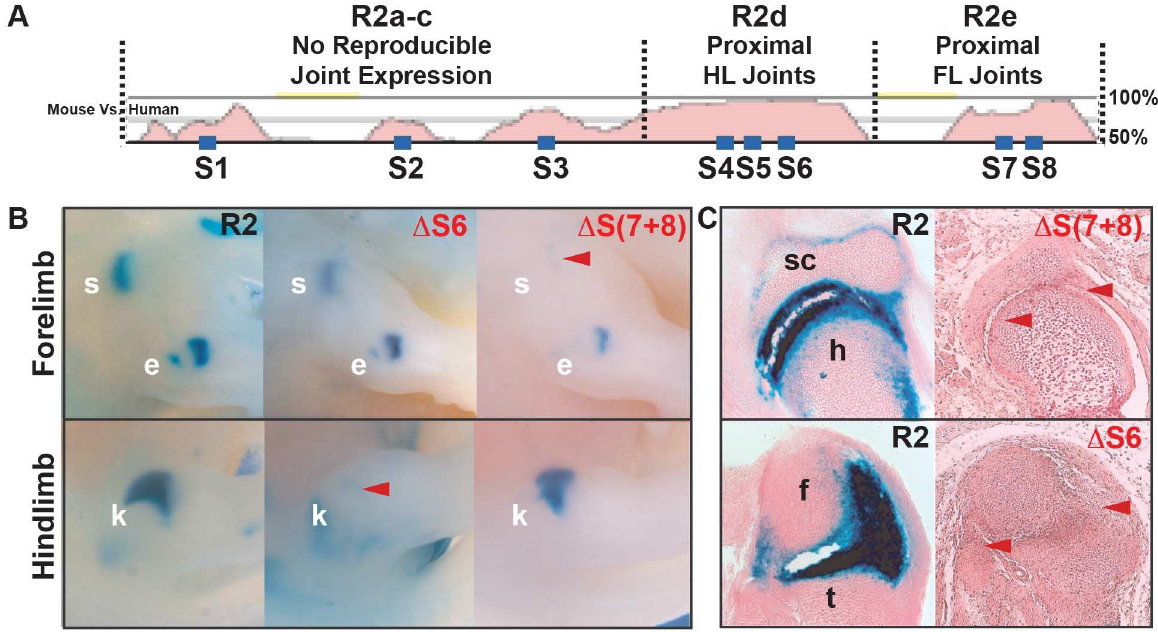
Fig 3. Predicted homeodomain binding sites are required for R2 expressiondomains in specific joints. ( A ) Eight predicted homeodomain bindingsites (S1-S8, blue boxes) are found across R2 subregions. Four of these UNIPROBE predicted sites are found in both mice and humans, includingS2 in sub-regionR2a-c, S5 and S6 in sub-region R2d, and S8 in sub-regionR2e. ( B ) Targeted mutagenesis of conservedS6 within the hindlimbregulatoryzone of R2 eliminates normal lacZ signalin the knee (red arrowhead)but not elbowor shoulder,tissues where this enhancer region is predictedto have little to no influenceon expression. Mutagenesis of sites S(7+8) within the forelimb regulatory zone of R2 eliminatesexpressionin shoulder(red arrowhead)but not elbowor knee, tissues where this sequenceis predicted to have little to no influence on expression. ( C ) Histology at E14.5 of wild-typeR2 (left) versus mutant R2 (right) constructs reveals specific reductions (red arrowheads) in joint domainsfor each construct. Abbreviations: s, shoulder;e, elbow; k, knee; sc, scapula;h, humerus; f, femur; t,